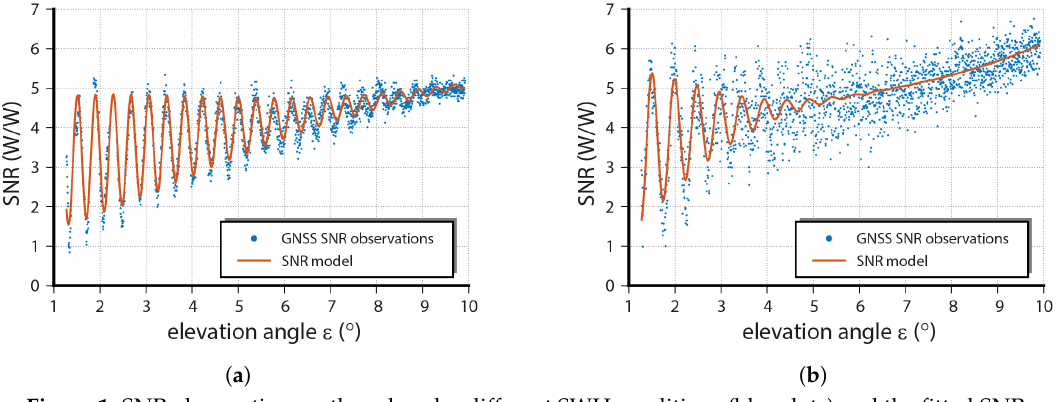
Figure 1. SNR observations gathered under different SWH conditions (blue dots) and the fitted SNR model (red). ( a ) SNR observations during SWH of 0.3m. ( b ) SNR observations during SWH of